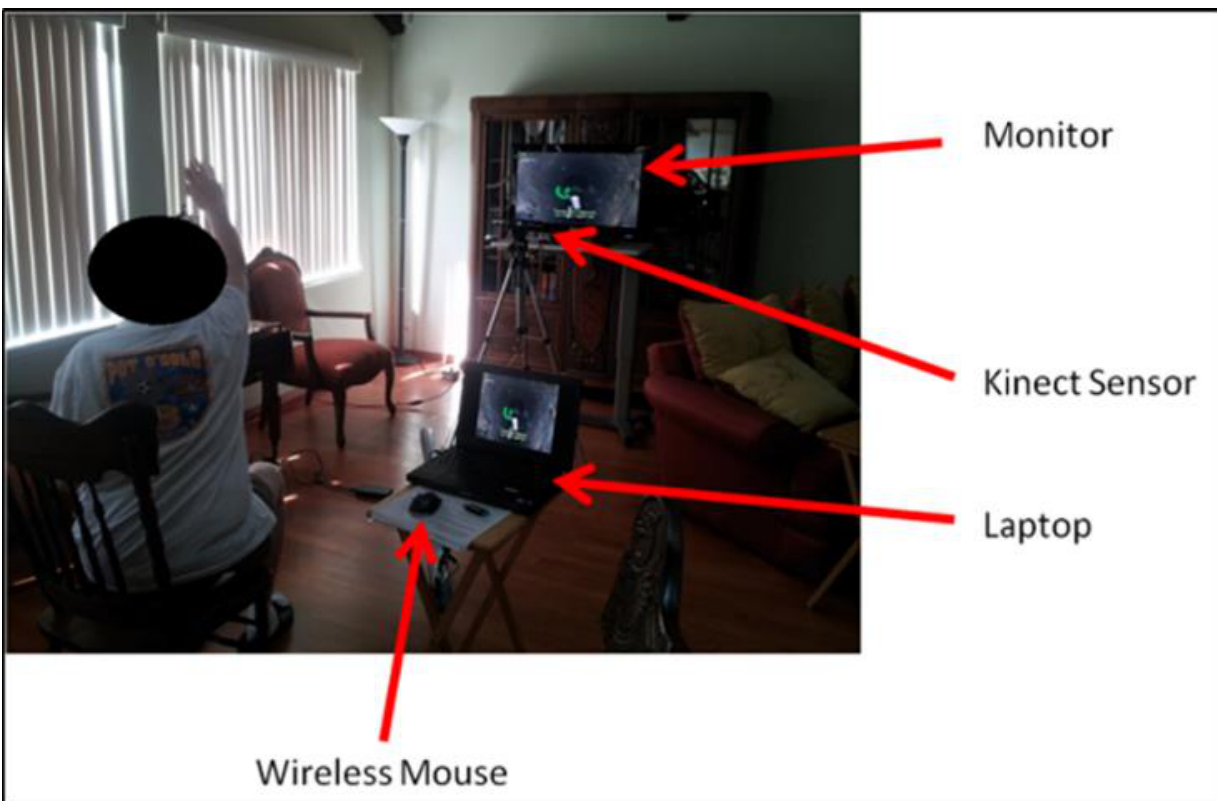
Figure 1. Mystic Isle game set-up in a participant's home. The participant is seated and reaching forward with his right arm. Visible are the monitor, the Kinect sensor, the laptop, and the wireless